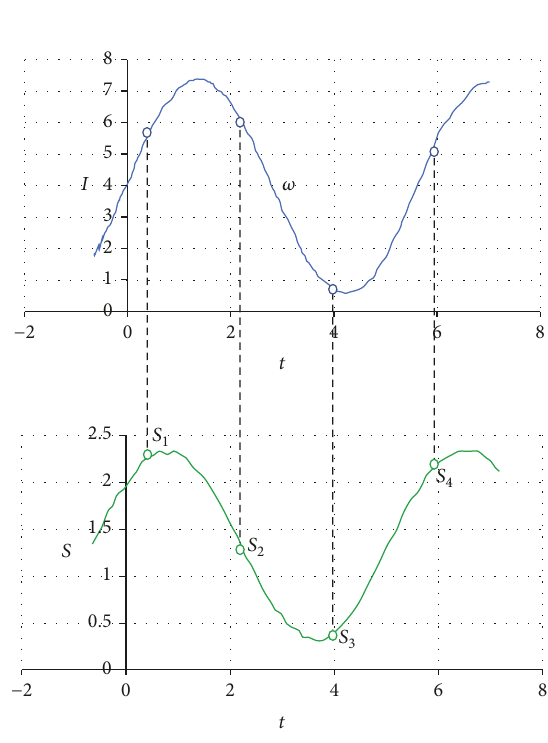
Figure 2: Amplitude and phase obtained by a sinusoidal thermal